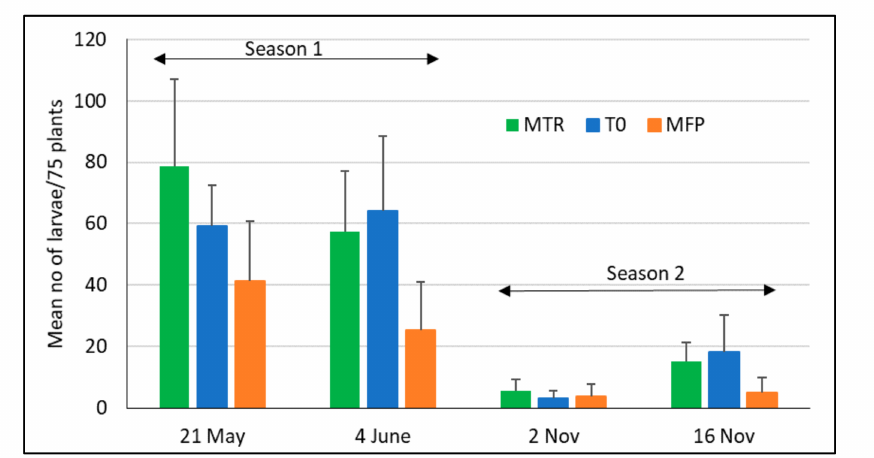
Figure 6. Mean (+SD) FAW larval numbers during the two maize growing seasons in Ghana in 2020. MTR = T. remus release plots; T0 = plots without T. remus releases, no pest control; MFP = farmers’ conventional practice including chemical pest control; 4 replicates per treatment and